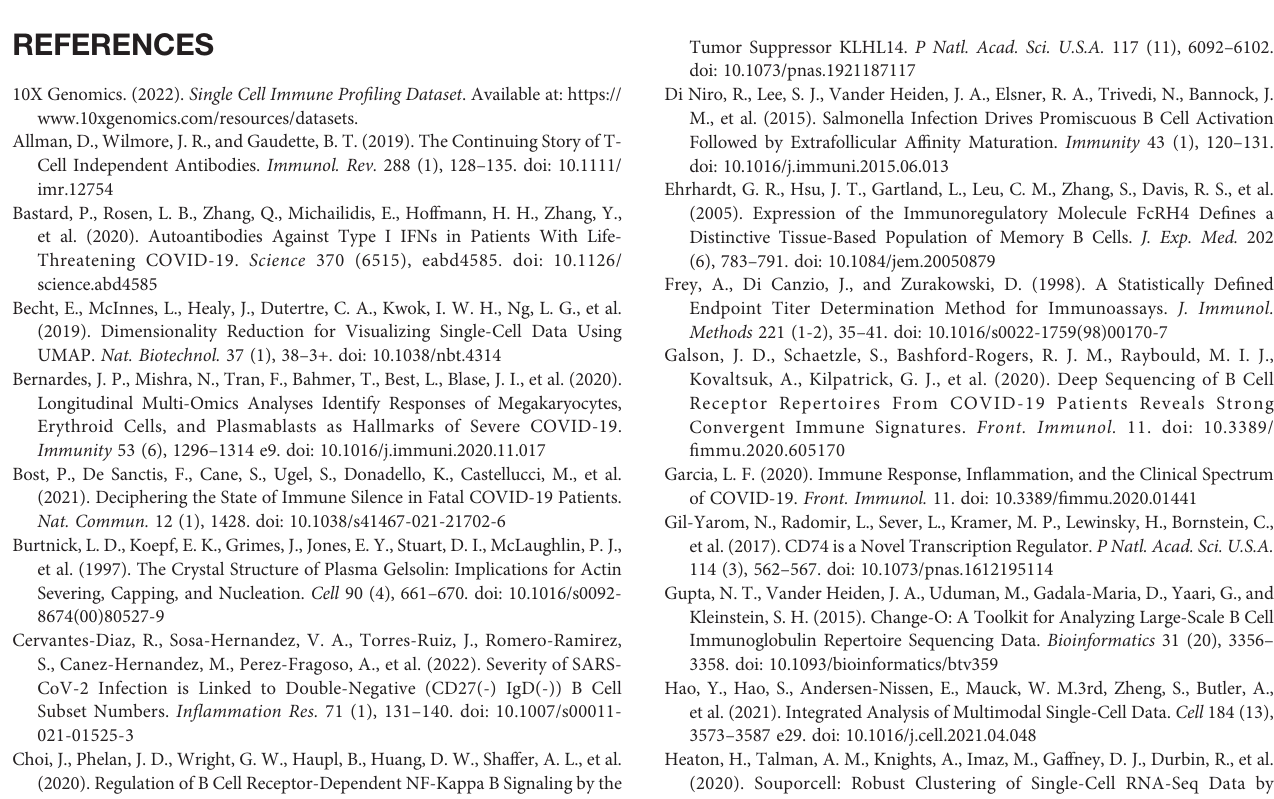
Supplementary Figure 4 | Cellular distribution of B cells from individual patient on trajectory UMAP of plasmablasts and plasma cells (see ). Supplementary Figure 5 | Boxplots for cellular proportions of B cells (A) and plasma cells (B) in PBMCs. Statistical signi fi cance was calculated by Wilcoxon rank sum test: ***, p <0.0001. NS, not signi fi cant. Supplementary Figure 6 | Anti-spike RBD IgA response and neutralizing activity in plasma from COVID-19 patients. (A) Violin plot presenting anti – SARS-CoV-2 spike RBD-speci fi c titers for IgA (left panel) and correlation of anti-RBD-speci fi c IgA titers with average homogeneity score of COVID-19 patients (right panel). (B) Violin plot presenting anti – SARS-CoV-2 FRNT 50 (left panel) and correlation of neutralizing titers with average homogeneity score of COVID-19 patients (right panel). Statistical signi fi cance was calculated by Pearson correlation. Supplementary Figure 7 | Difference in tentative EF B cell subsets (AN and AM) proportion among naïve and memory B cell population between survived and deceased patients after admission in ICU. Tentative EF B cells were identi fi ed from the B cell dataset reported previously (Bost et al., 2021). Plasma cells were barely detected in this dataset due to poor data quality. Supplementary Figure 8 | Bar plots of signi fi cant GO terms signi fi cantly upregulated in the indicated B cell subsets (RN and SM) when compared to AN and AM2, respectively (see ). Supplementary Figure 9 | Heatmap of representative DEGs showing the statistically signi fi cant difference among three EF B cell subsets. Supplementary Figure 10 | Computed hallmark gene set activity scores of indicated categories among B cell subsets. Statistical signi fi cances between AM2 and other B cell subsets were calculated by Wilcoxon rank sum test: ***, p <0.0001; **, p <0.001; *, p